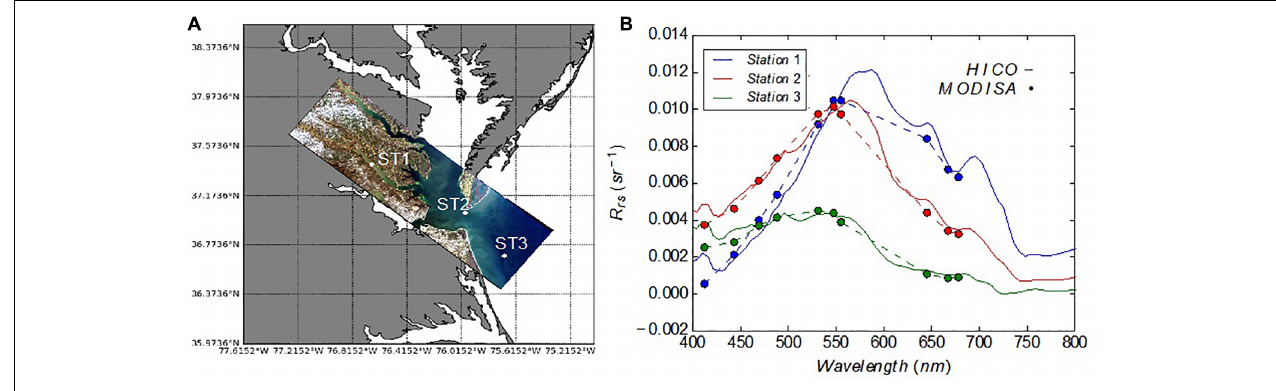
FIGURE 11 | (A) HICO true color image at the Chesapeake Bay waters. (B) the retrieved Rrs at three different locations from HICO and MODIS Aqua after atmospheric correction and water vapor correction using the k -distribution method for gaseous absorption. This figure has been adapted from Ibrahim et al. (2018).